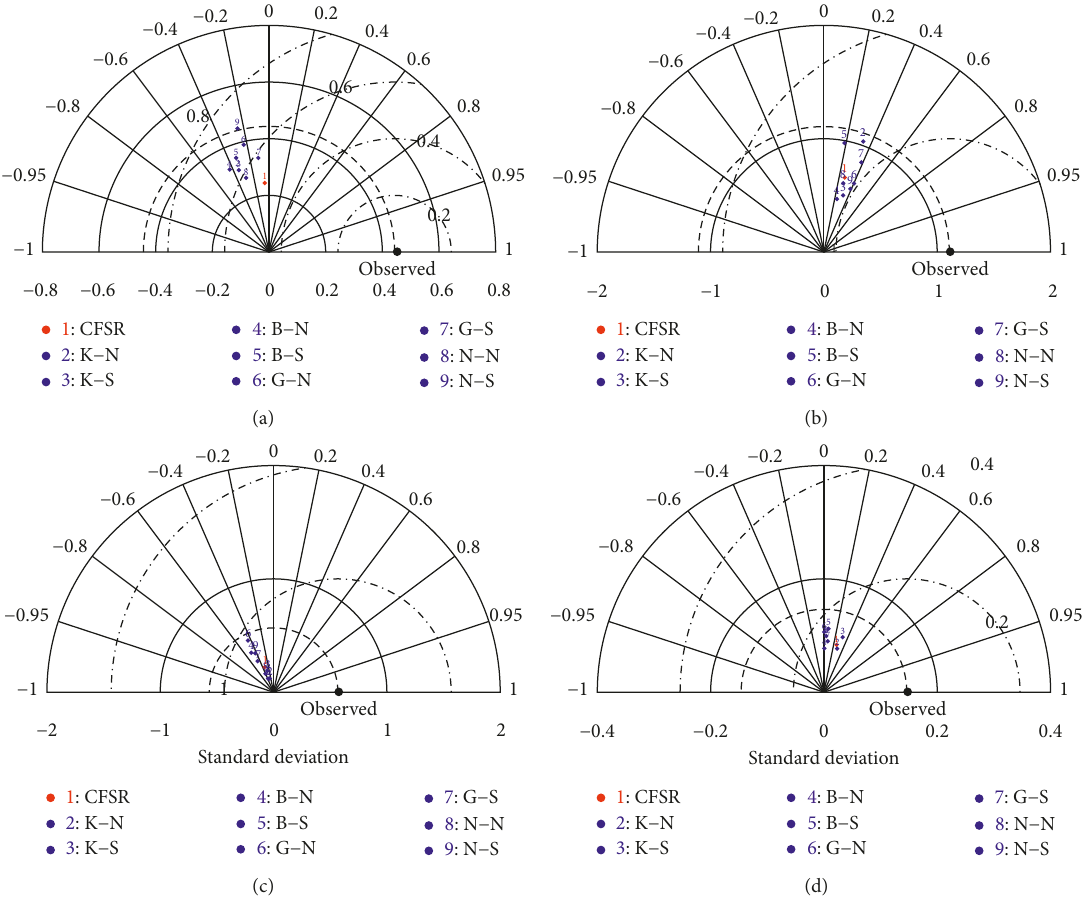
Figure 5: Taylor diagram of the areal-averaged seasonal precipitation forecast skill of CFS reforecasts and the WRF model coupled with different convective and land surface parameterization schemes. (a) Spring. (b) Summer. (c) Autumn. (d)